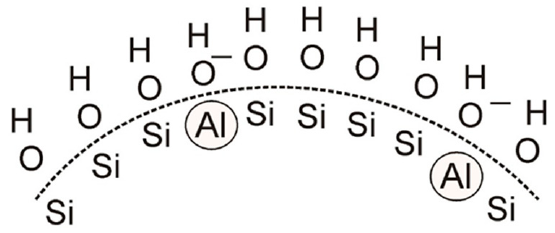
Figure 6. Charge formation on the surface of SiO 2 particles in the binder stabilized with an aluminium salt, adapted from [53].